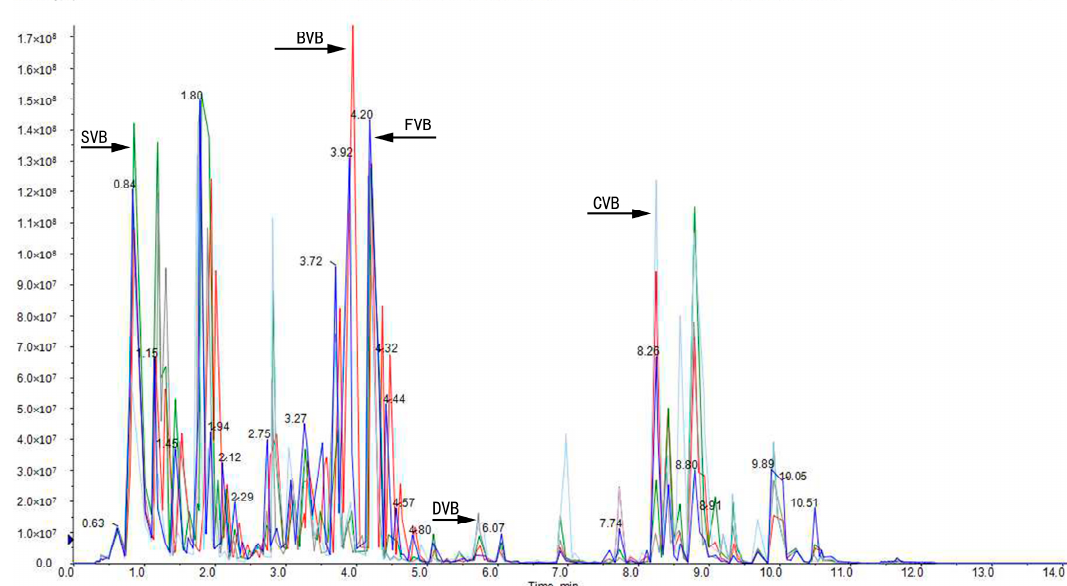
Figure 1. Liquid chromatography–tandem spectrometry (LC–MS/MS) base peak intensity (BPI) profiles of metabolites different processed vanilla beans (FVB (fresh vanilla bean): Blue, BVB (blanched vanilla bean): Red, SVB (sweating vanilla bean): Green, DVB (drying vanilla bean): Gray, and CVB (cured vanilla bean): Light blue).